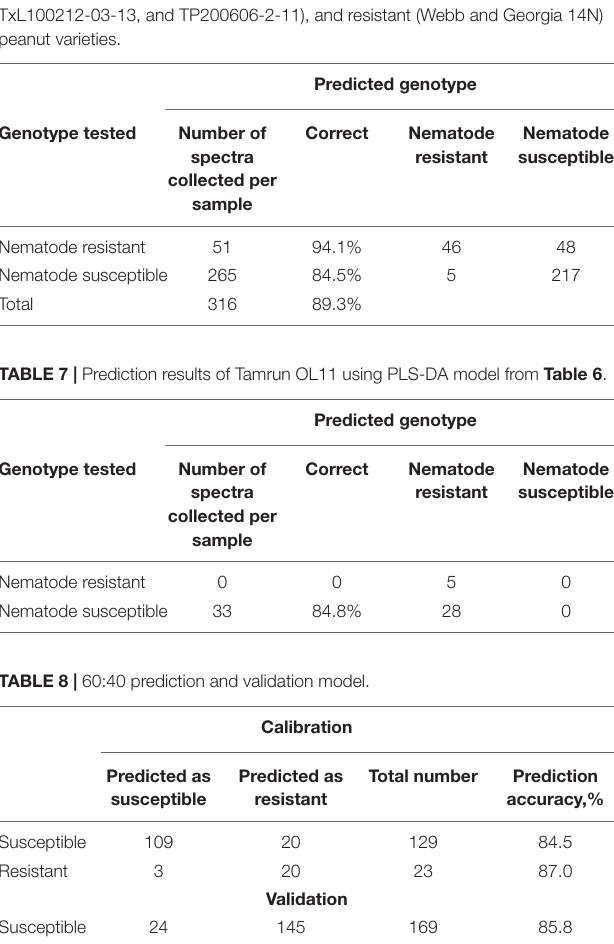
TABLE 6 | PLS-DA model that is based on susceptible (Georgia 09B, TxL100212-07-07, TxL100212-02-05, TxL100212-05-09, Tx121082,